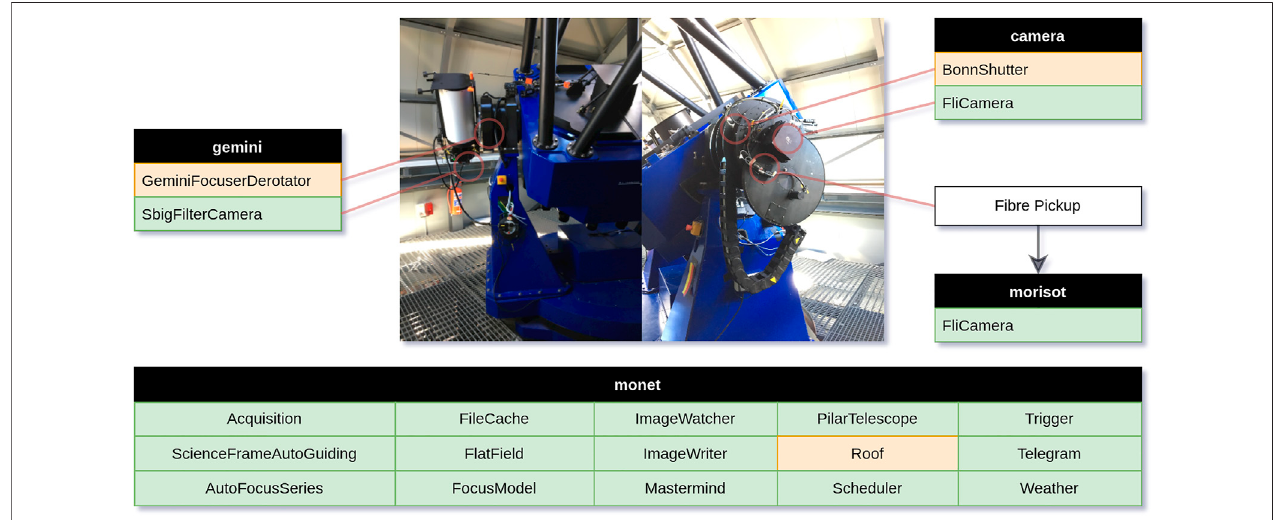
FIGURE 10 | List of all pyobs modules that are currently running at MONET/S and how they are distributed to four different computers. Marked in green are those modules that are available in pyobs-core or one of the additional packages. The three other modules are custom implementations for the given hardware.